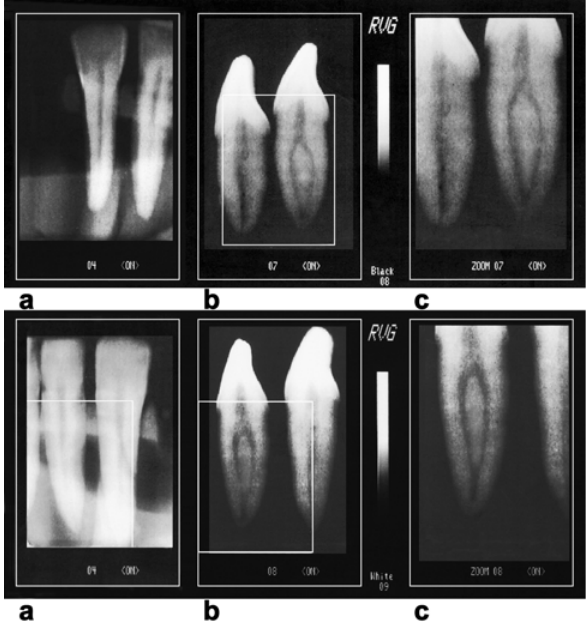
FIGURE 6- Images of in vitro study: a) orthoradial digital radiography of canine in the BL direction, b) digital radiograph in the MD direction, c) magnification of digital radiograph in the MD direction